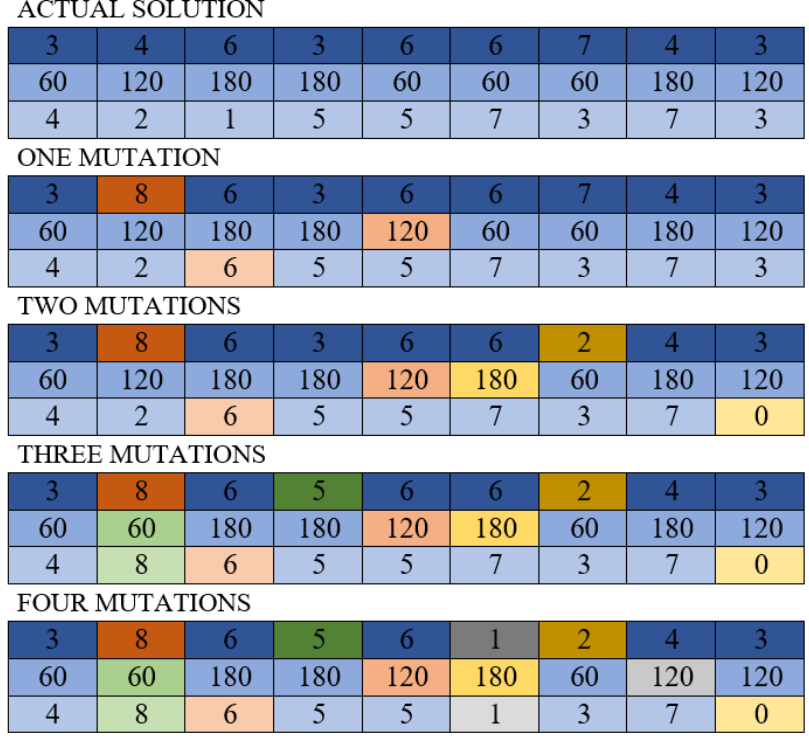
Figure 8. Mutation process from one to four mutations.